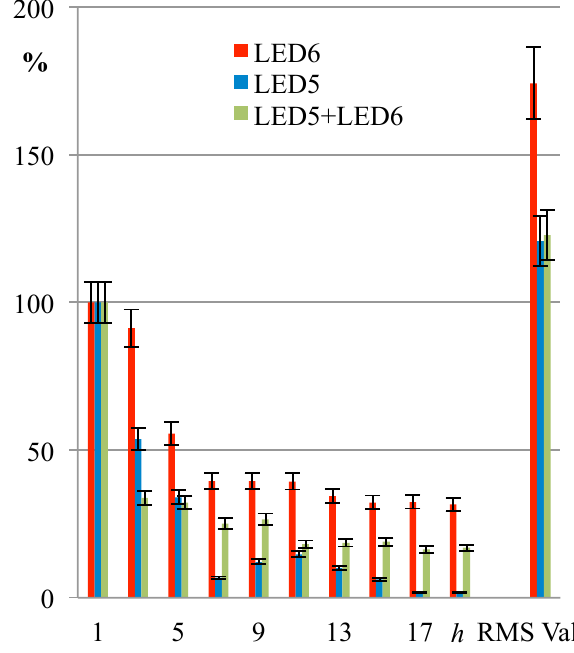
Figure 7: Harmonic currents content in one phase conductor of a four–core cable for a selected LED–LED combination. In order to better show the contribution of the proposed solution, the measured spectrum of the harmonic currents (expressed in per–unit of the fundamental harmonic current), both in one phase and in the neutral conductor of a four–core cable, feeding balanced single–phase loads formed by respectively. The corresponding spectrums for the